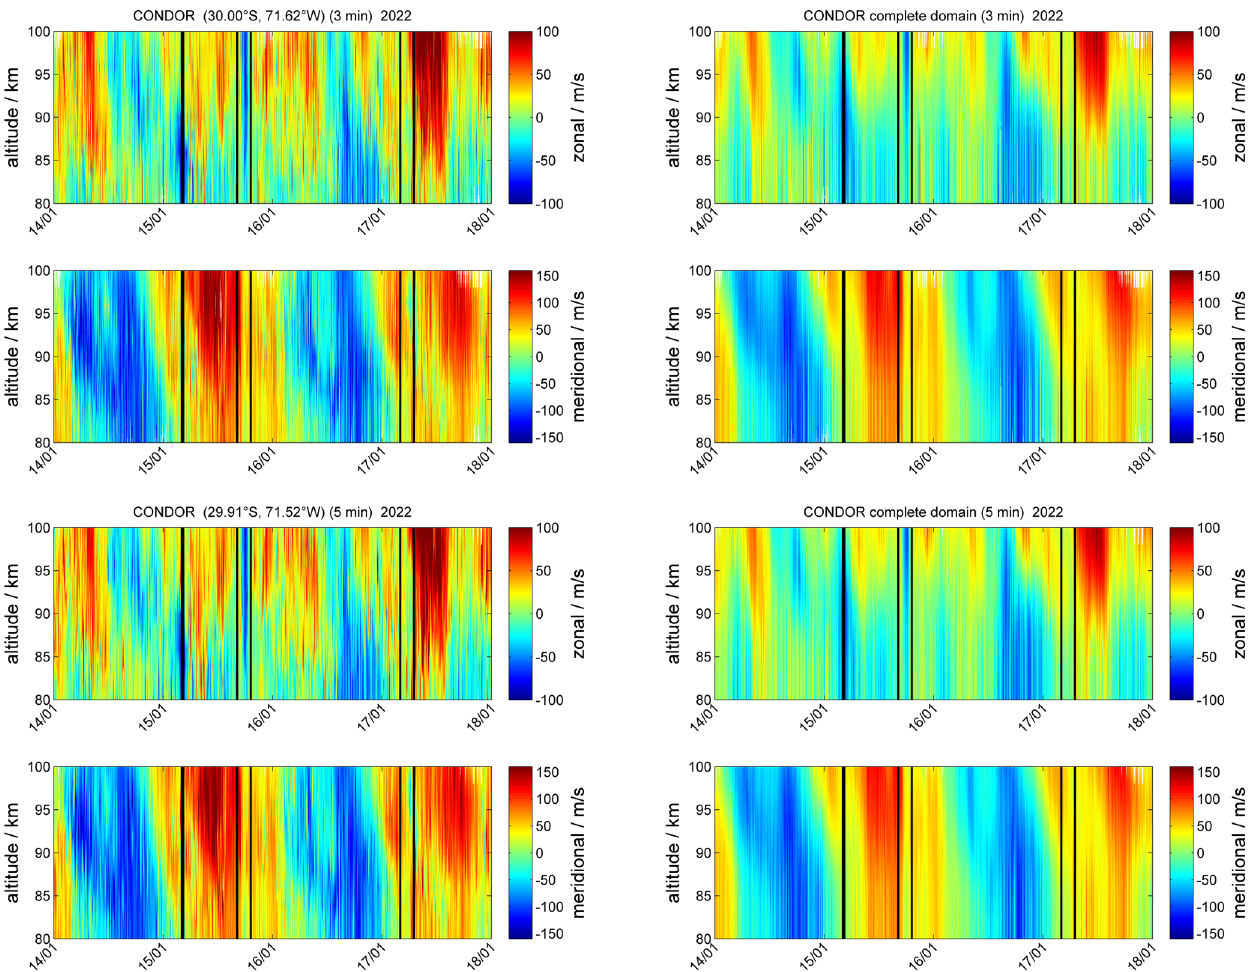
Figure A1. Zonal and meridional winds from the 3DVAR+DIV retrieval with temporal resolutions of 3 and 5min. The left panels show the zonal and meridional winds for a single grid cell centered at geographic coordinates 30 ◦ S, 71.62 ◦ W and 29.91 ◦ S, 71.52 ◦ W, respectively. The four right panels present the zonal and meridional winds integrated/averaged over the entire CONDOR domain.